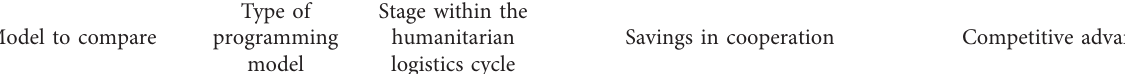
Table 1: Comparative table between the contribution made against different models developed. Model to